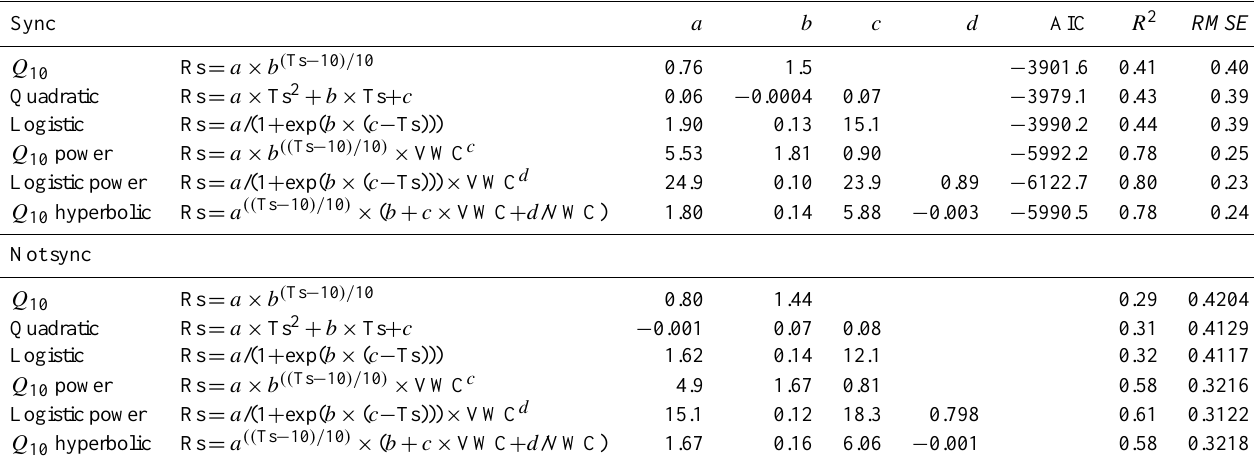
Table 3. Regression parameters ( a , b , c , d) from univariate and bivariate models of soil respiration on the basis of synchronized and